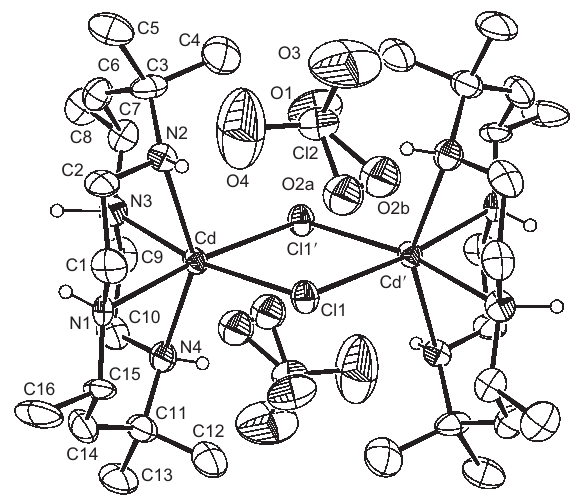
Figure 1 An ORTEP view of [Cd(L)( µ -Cl)] atomic numbering scheme (30 % probability ellipsoids shown).